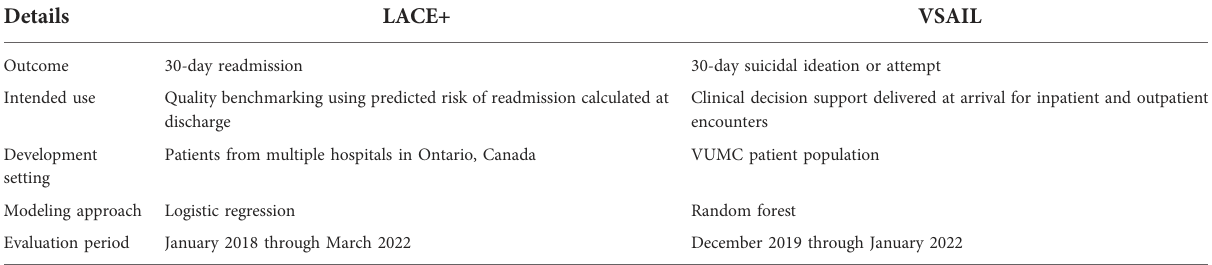
TABLE 1 Prediction models evaluated for temporal validation of real-time scores generated within a production electronic medical record